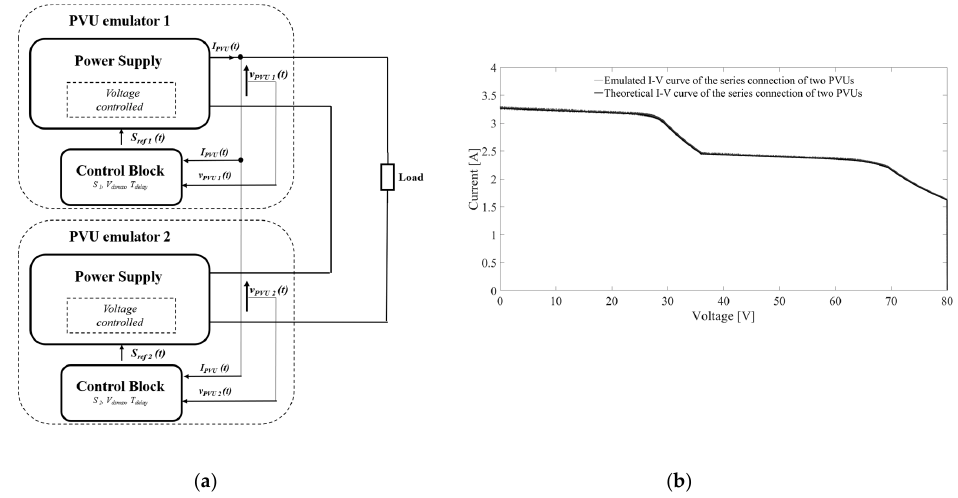
Figure 16. Performance of series connection of two Boost PVU emulators: ( a ) block diagram of system under test; ( b ) S 1 = 400 W / m 2 , S 2 = 300 W / m 2 , T = 57.5 ◦ C, and V dsmax = 40 V.